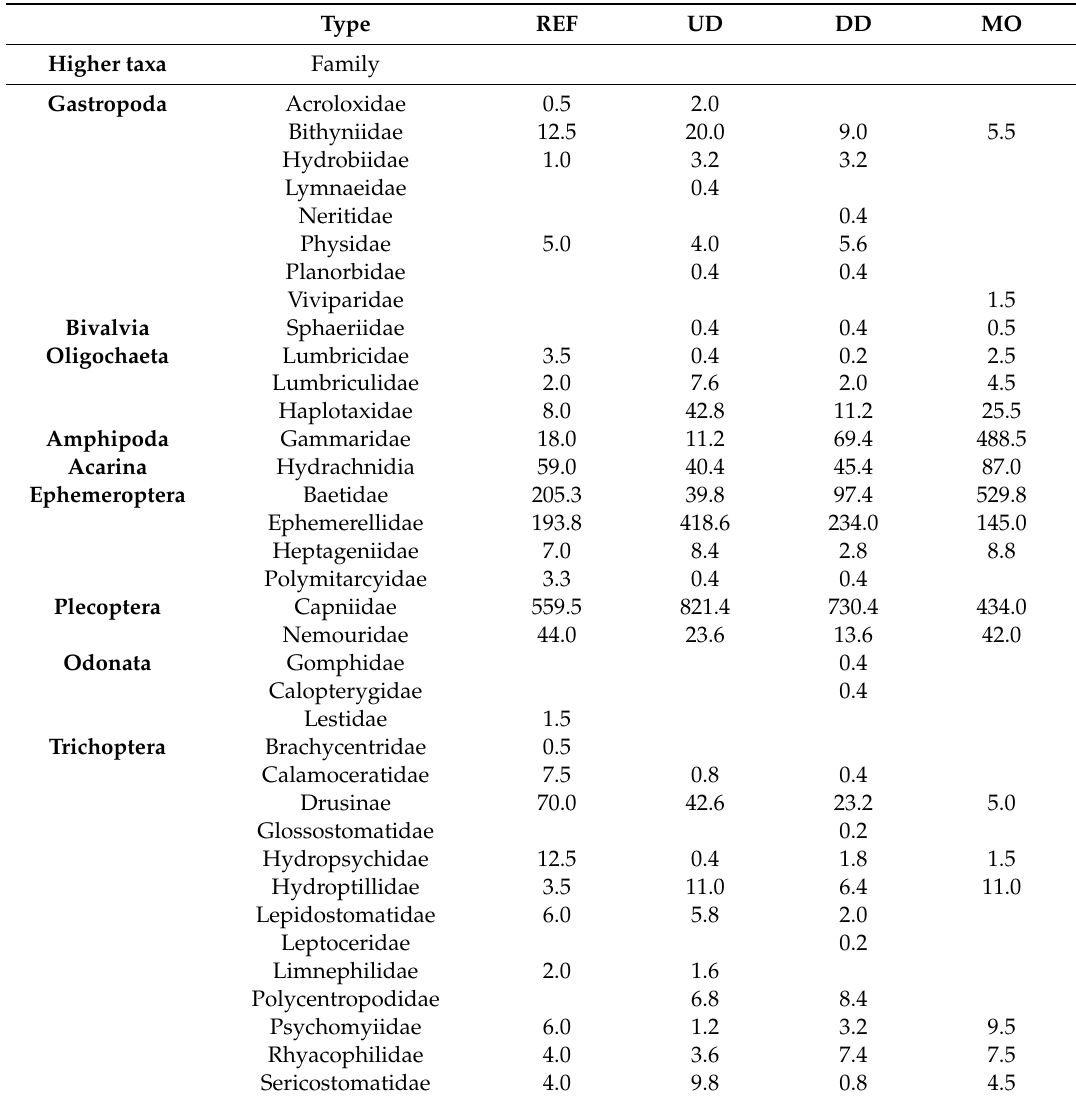
Table A1. Average numbers of macroinvertebrate individuals per sample in four types of reaches. L—larvae,